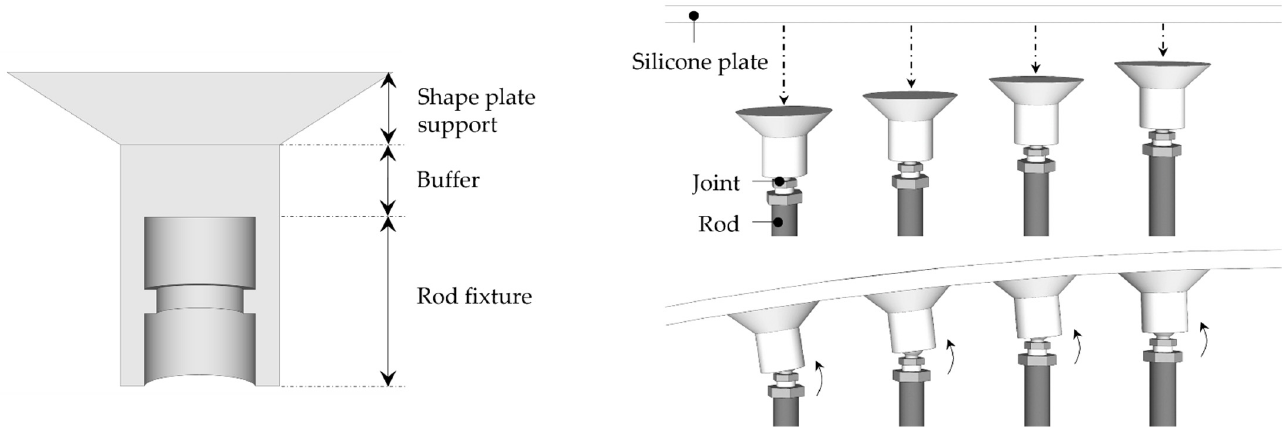
Figure 5. Detachable-type silicone cap.